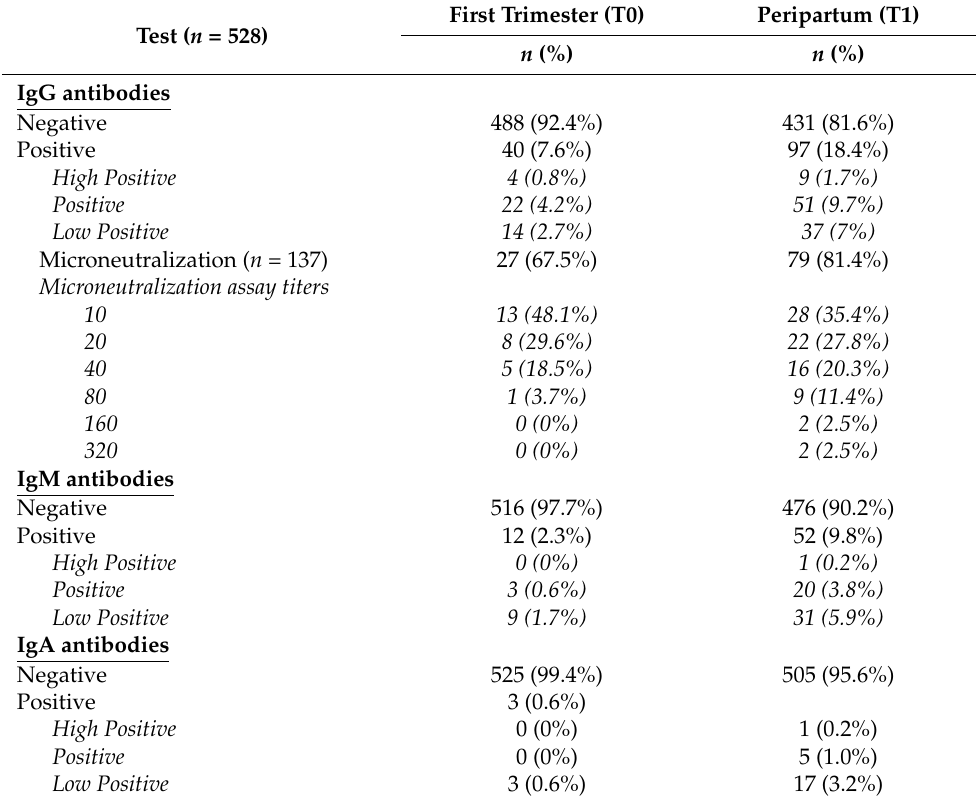
Table 3. IgG, Microneutralization assay titers, IgM, and IgA in the first trimester of pregnancy (T0) and peripartum